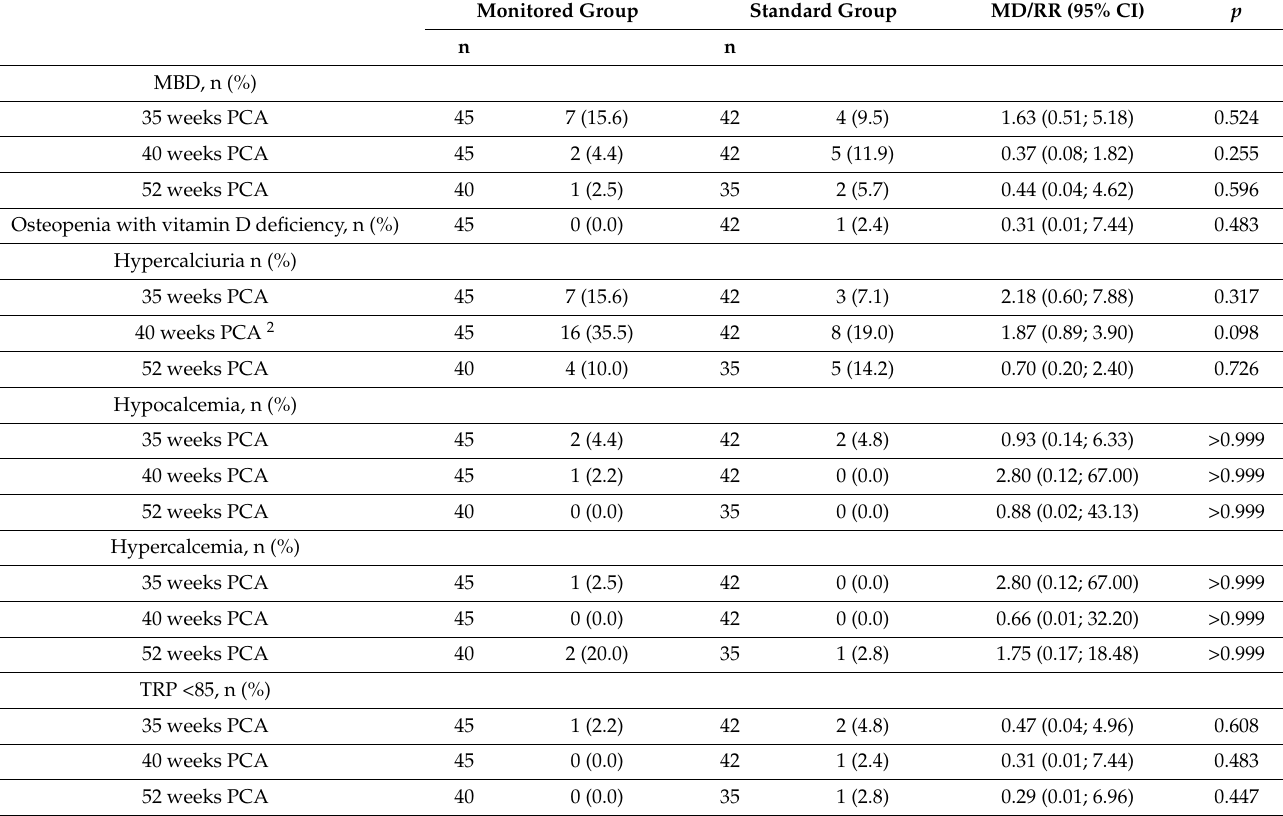
Figure 4. Diagram of mean 25(OH)D concentrations. 25(OH)D: 25-hydroxyvitamin D; * statistically significant. There was no difference in the secondary objectives (Table 4). Table 4. Secondary outcomes between groups.